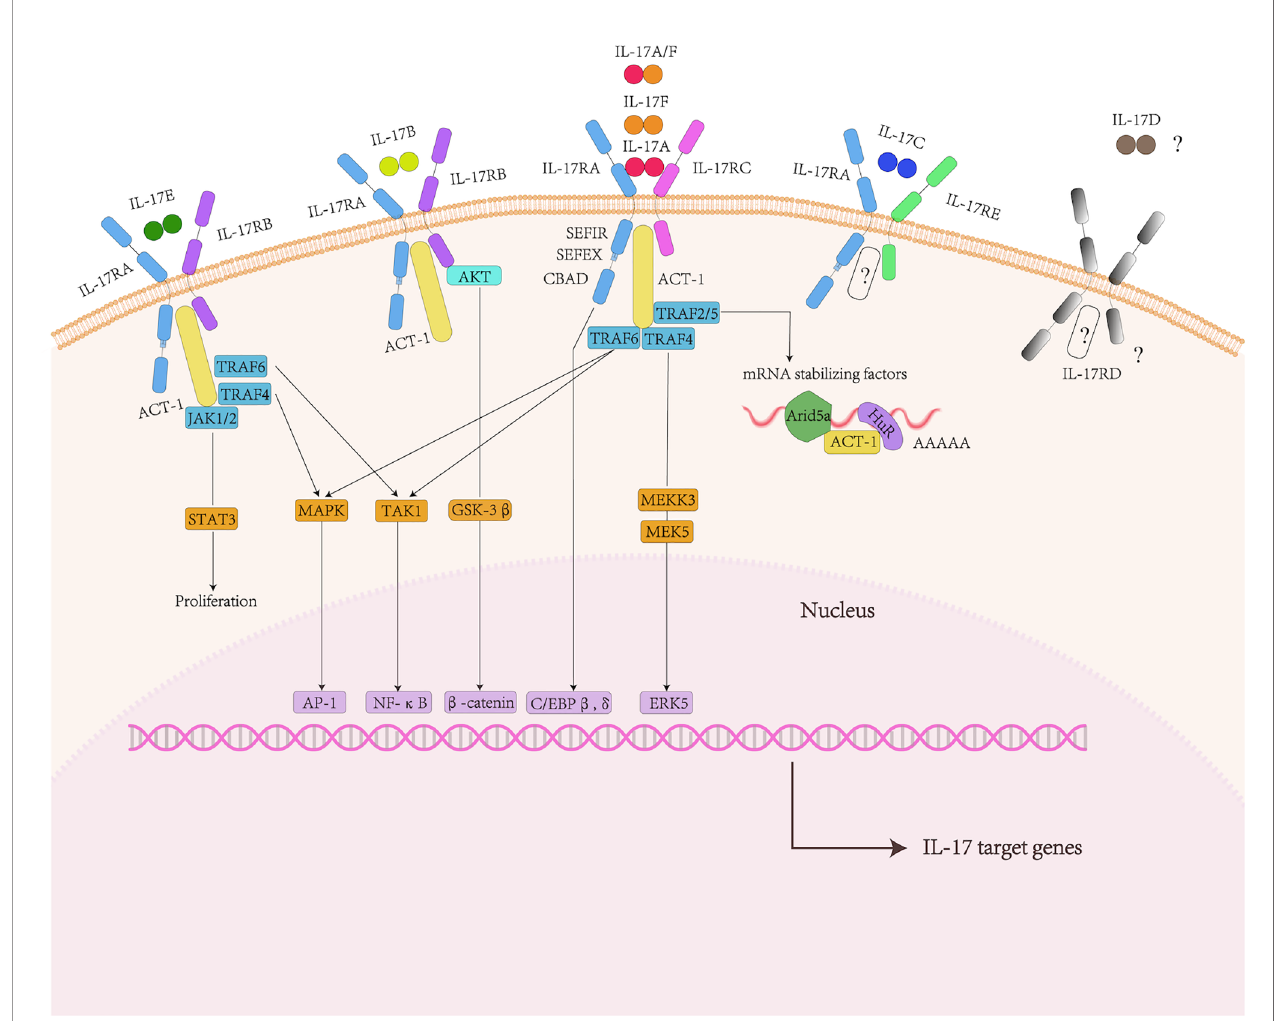
FIGURE 1 | IL-17 family and signaling pathway. The IL-17 family includes six factors and fi ve receptors. IL-17RA and IL-17RC subunits bind to IL-17A, IL-17F and IL-17AF ligands. IL-17RA and IL-17RB subunits bind to IL-17B and IL-17E ligands. The receptors of IL-17C are IL-17RA and IL-17RE. IL-17D and IL-17RD are currently unknown. They shared the common cytoplasmic motif SEFIR domain can recruit act1 and nonconserved region called SEFEX.ACT-1 can bind to TRAF family proteins. For IL-17A, TRAF6 can activate NF- k B pathway, MAPK/ap1 pathway. Act1 can also promote post-transcriptional mRNA stabilization through the transcriptional induction of TRAF2/5. In addition, The Il-17R-act1 complex binded to MEKK3 and MEK5 via TRAF4 to activate ERK5. In addition to the classic pathway, IL-17E also mediates Act1-JAK1/2-STAT3